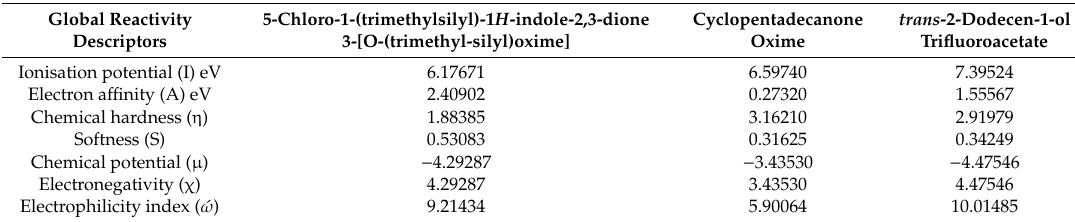
Table 3. Global reactivity descriptors values in the gas